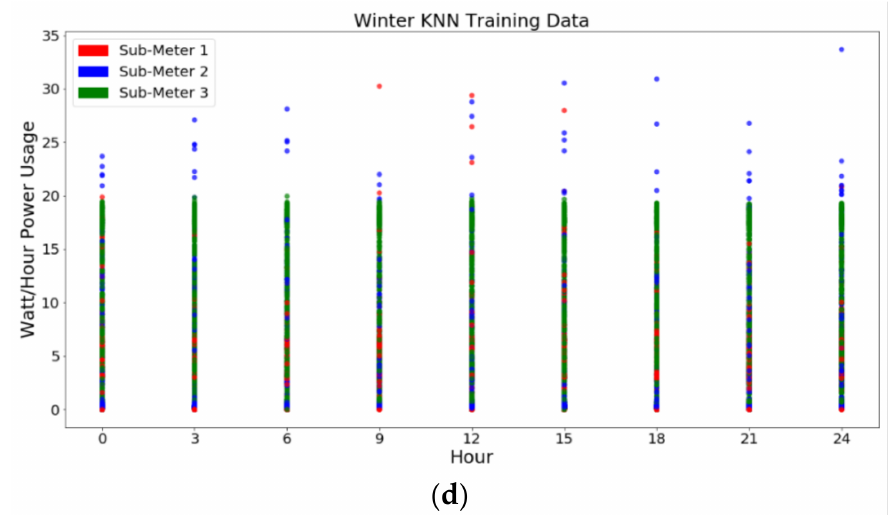
Figure 6. KNN data distribution among all the seasons: ( a ) fall data distribution; ( b ) spring data distribution; ( c ) winter data distribution; ( d ) summer data